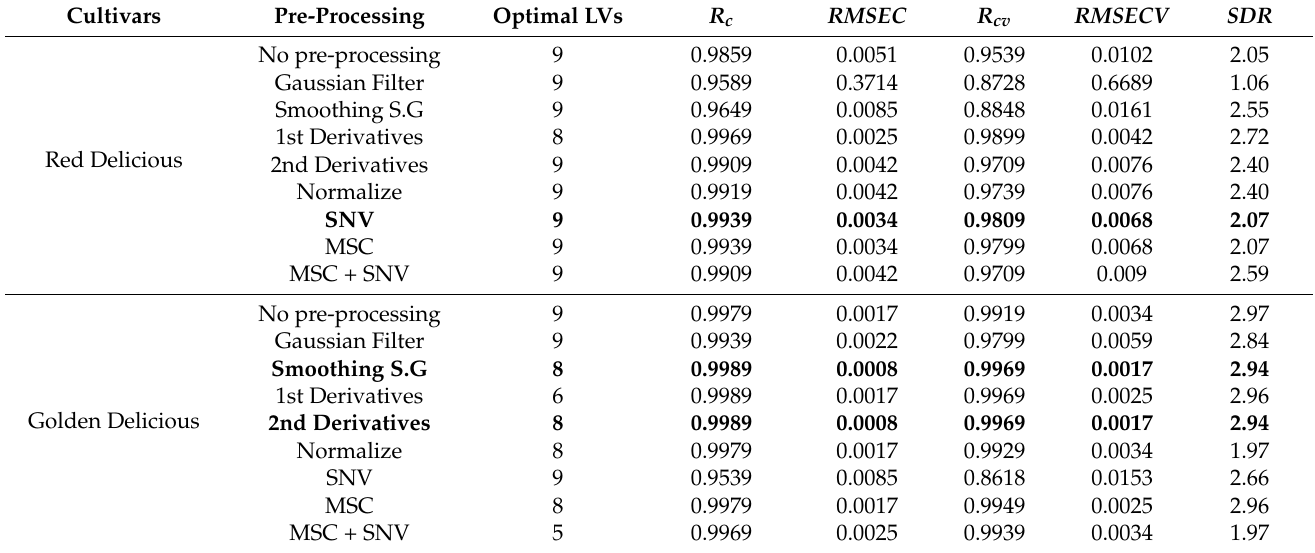
Table 4. Validation results of PLS models based on different hyperspectral imaging pre-processing methods for TA of Red Delicious and Golden Delicious cultivars.